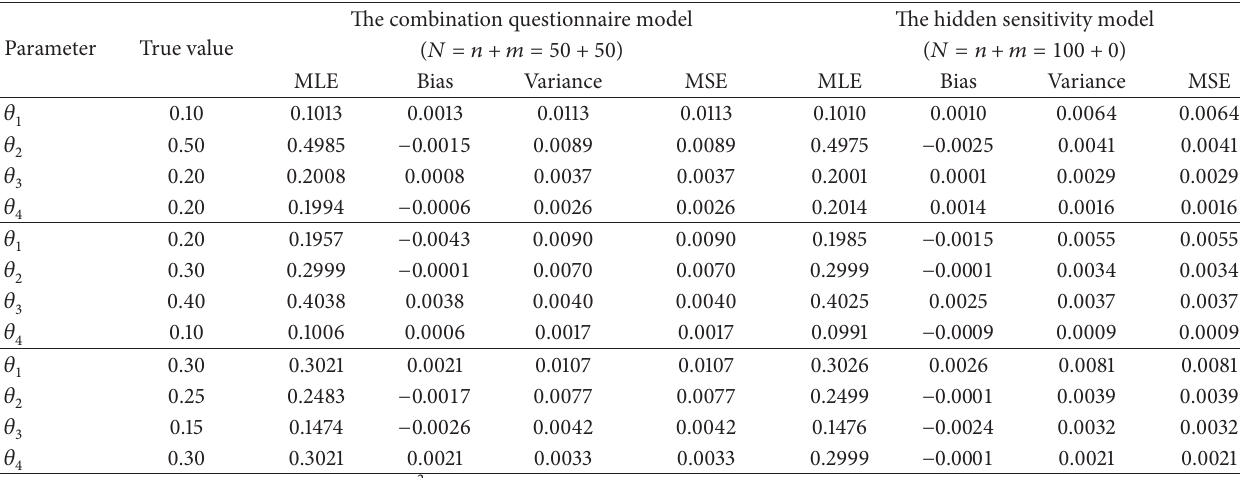
Table 5: Comparison of the efficiency of the proposed combination questionnaire model with that of the hidden sensitivity model of Tian et al. [8] (i.e., the main questionnaire model only) with (𝑝 1 ,𝑝 2 ,𝑝 3 ) = (1/3, 1/3, 1/3) .